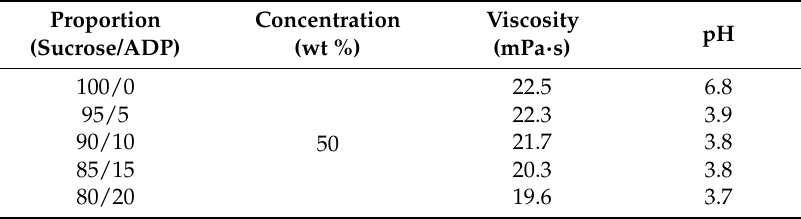
Table 1. Viscosity and pH of SADP adhesive solutions.